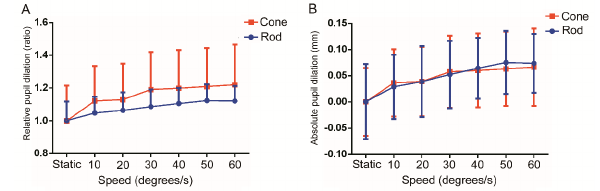
Figure. 3 The relative pupil diameter with static optotypes and moving optotypes at the speeds of 10, 20, 30, 40, 50, and 60 degrees/s in the cone- and rod-mediated paradigms (n=28). A. The relative ratio of pupil diameters; B. Absolute value of pupil diameter change. Table 3. Pupil diameter and pupil dilation of all speeds.